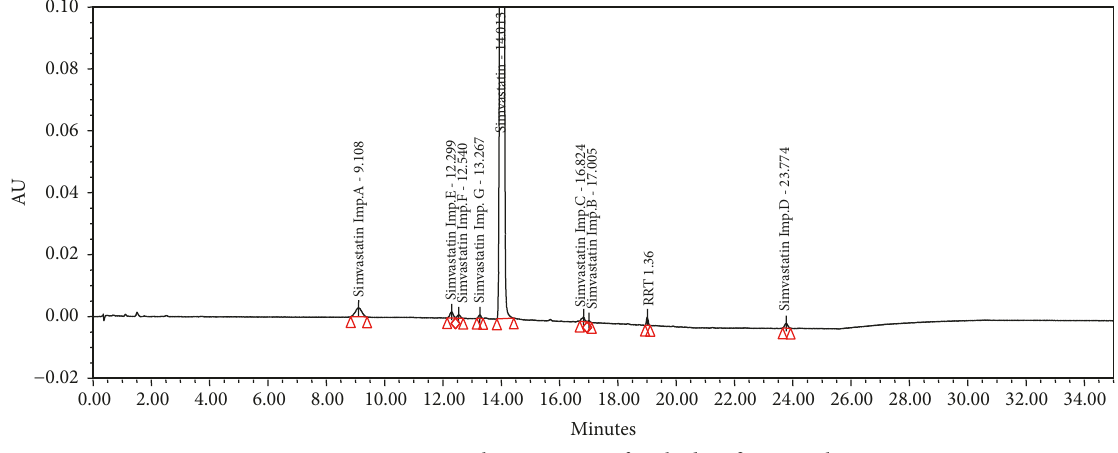
Figure 3: Representative chromatogram of peak identification